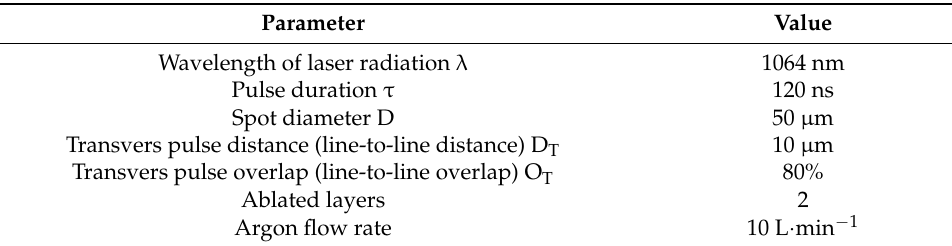
Table 1. Constant parameters of the experimental setup. Parameter Value Wavelength of laser radiation λ 1064 nm Pulse duration τ 120 ns Spot diameter D 50 µ m Transvers pulse distance (line-to-line distance) D T 10 µ m Transvers pulse overlap (line-to-line overlap) O T 80% Ablated layers 2 Argon flow rate 10 L · min − 1